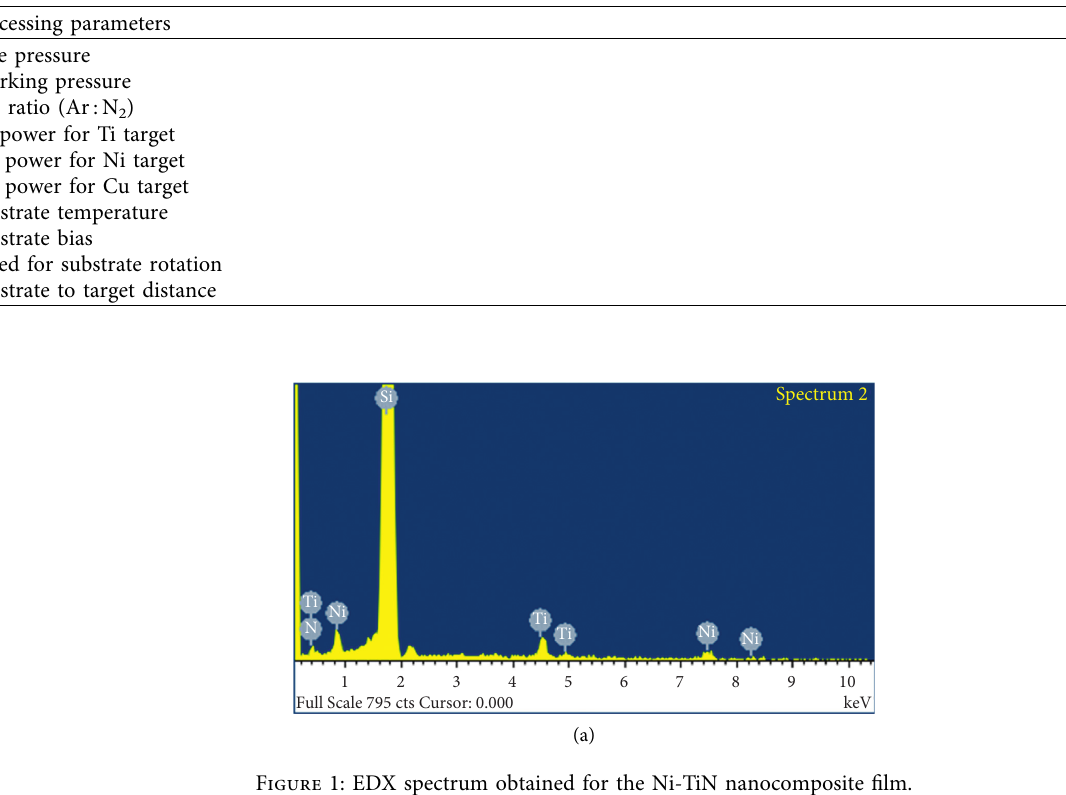
Table 1: The deposition parameters for the investigated thin